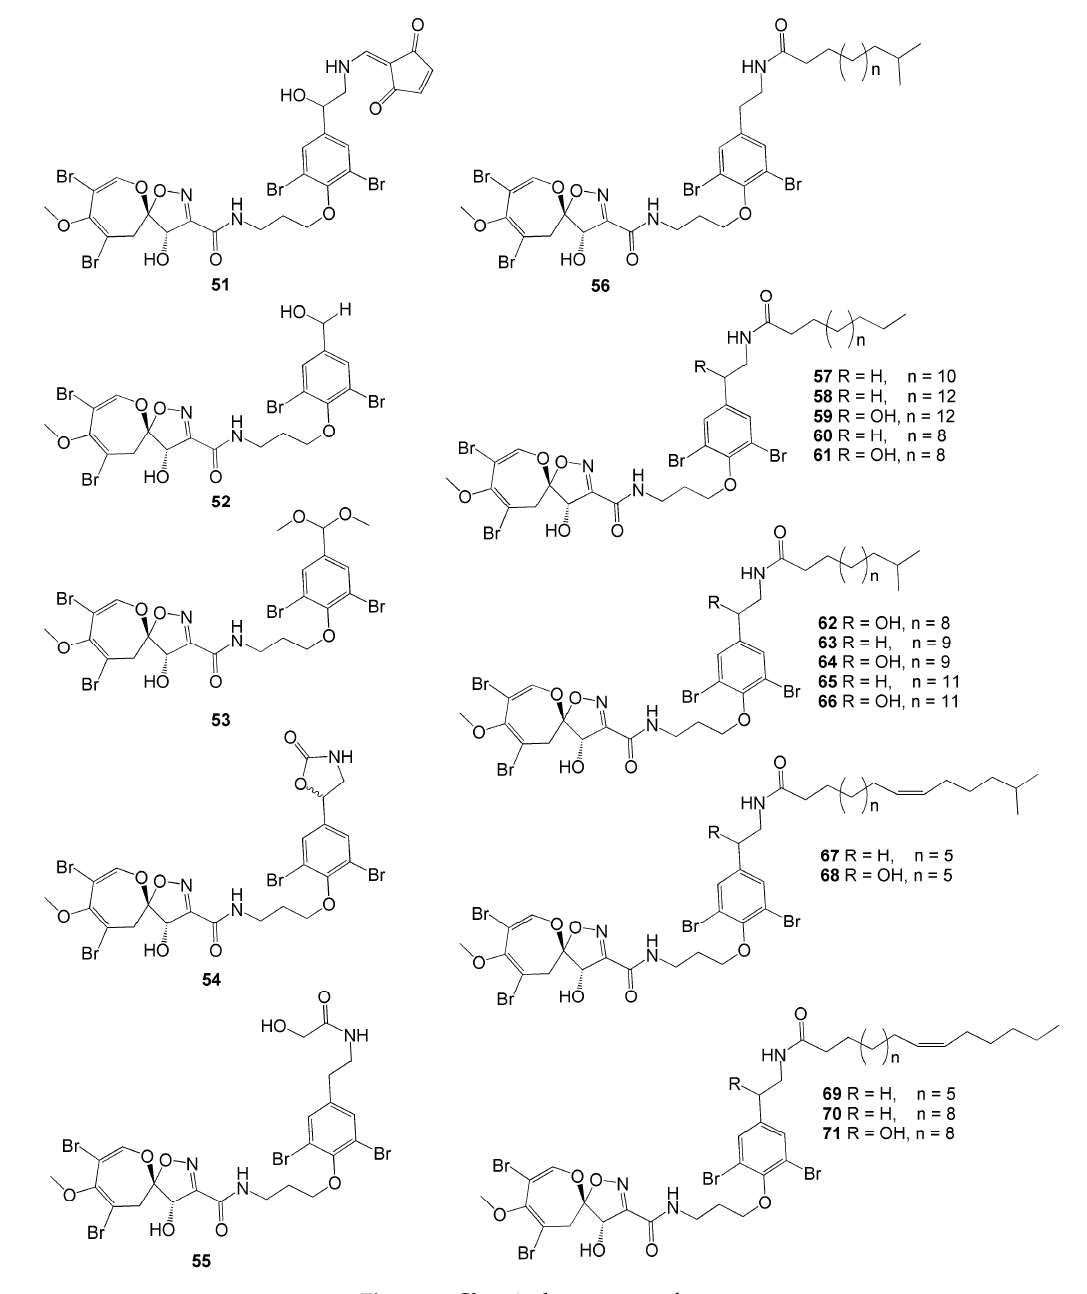
Figure 5. Chemical structures of 51 – 71. Other compounds isolated from Sulawesi included nakijiquinone V ( 83 ), isolated from Dactylospongia elegans from Tahuna, Sangihe Islands, North Sulawesi [39]. It has three methyl groups attached to a decalin system with an exocyclic double bond [39] (Figure 6). Another was a new meroditerpene—namely, Halioxepine ( 84 ), which was isolated from an Indonesian marine sponge from the genus Haliclona collected in Baubau, Southeast Sulawesi [40]. This compound showed moderate cytotoxicity against the rat bladder tumour NBT-T2 cells with IC 50 of 11.6 µ M and antioxidant activity against 1,1- diphenyl-2-picrylhydrazyl (DPPH) with IC 50 of 7.7 µ M [40]. Recently, two new terpenoids, melophluosides A ( 85 ) and B ( 86 ), were successfully isolated from Melophlus